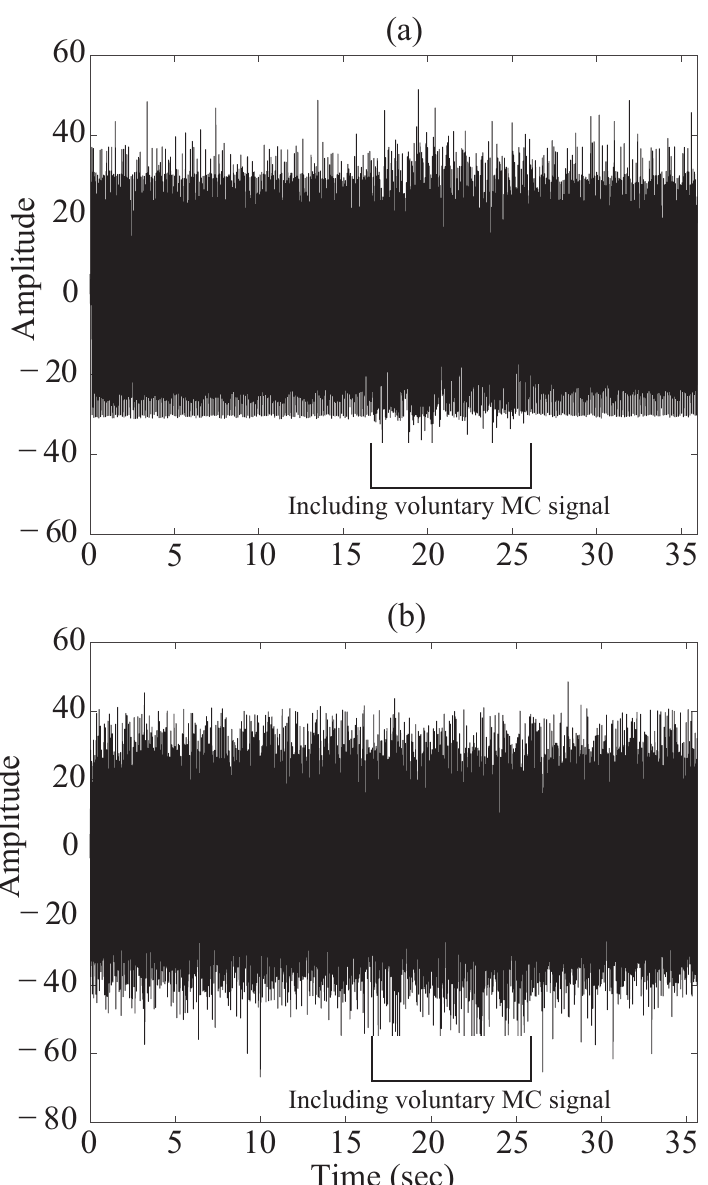
Figure 7. EMG waveformafter applying the ESS. ( a ) waveform by 10 Hz ES, ( b ) waveform by 90 Hz